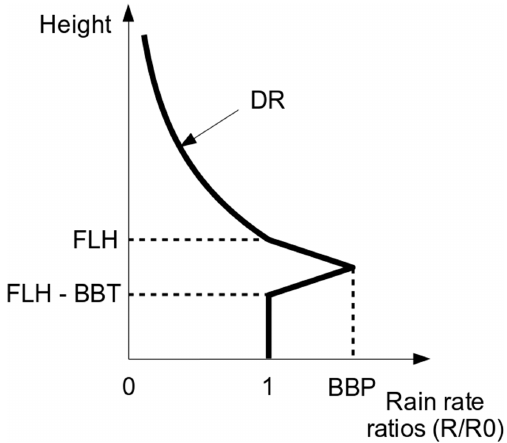
Figure 1. Idealised VPR used for the operational correction of re- flectivities (Tabary, 2007) expressed in terms of rain rate ratios. FLH: freezing level height; BBP: bright-band peak; BBT: bright- band thickness; DR: decreasing rate above the freezing